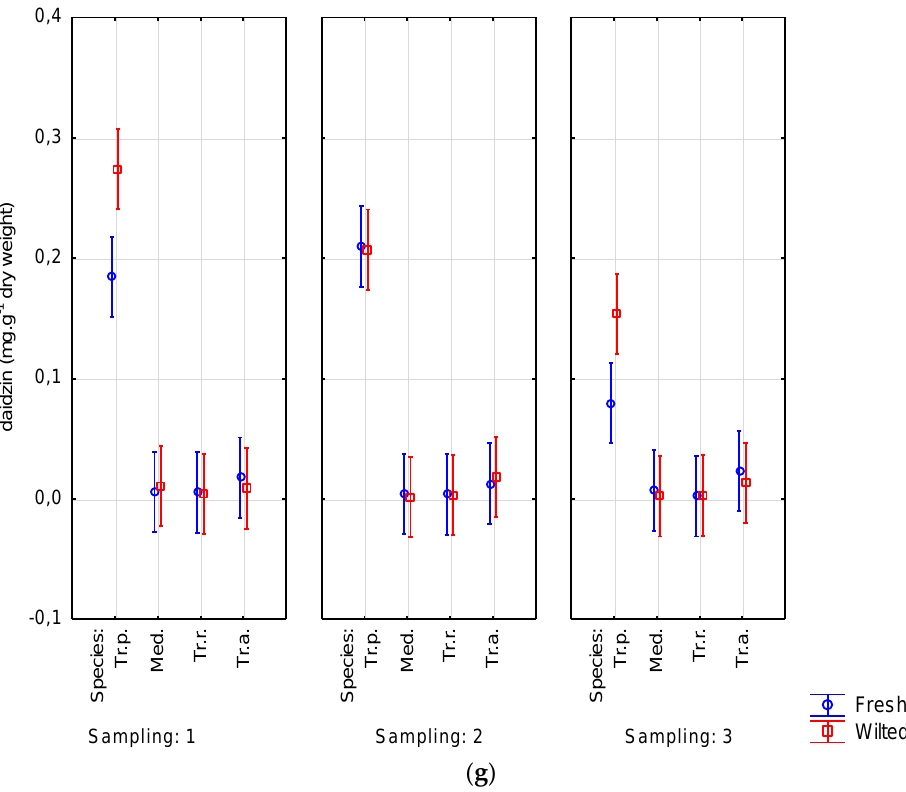
Figure 7. Wilting’s influence on contents of biochanin A ( a ); formononetin ( b ); genistein ( c ); ononin ( d ); sissotrin ( e ); daidzein ( f ); and daidzin ( g ) from Sampling 1 to Sampling 3 (mg·g −1 of dry matter) in Medicago sativa (Med.), Trifolium pratense (Tr.p.), Trifolium resupinatum (Tr.r.), and Trifolium alexandrinum (Tr.a.). Error bars indicate 95% confidence interval. Table 3. Total isoflavone content in forage of Trifolium pratense , Medicago sativa , Trifolium resupinatum , and Trifolium alexandrinum (% of dry matter). Species Overall Representation of Isoflavones Trifolium pratense L. 1.001 Medicago sativa L. 0.056 Trifolium resupinatum L. 0.061 Trifolium alexandrinum L.